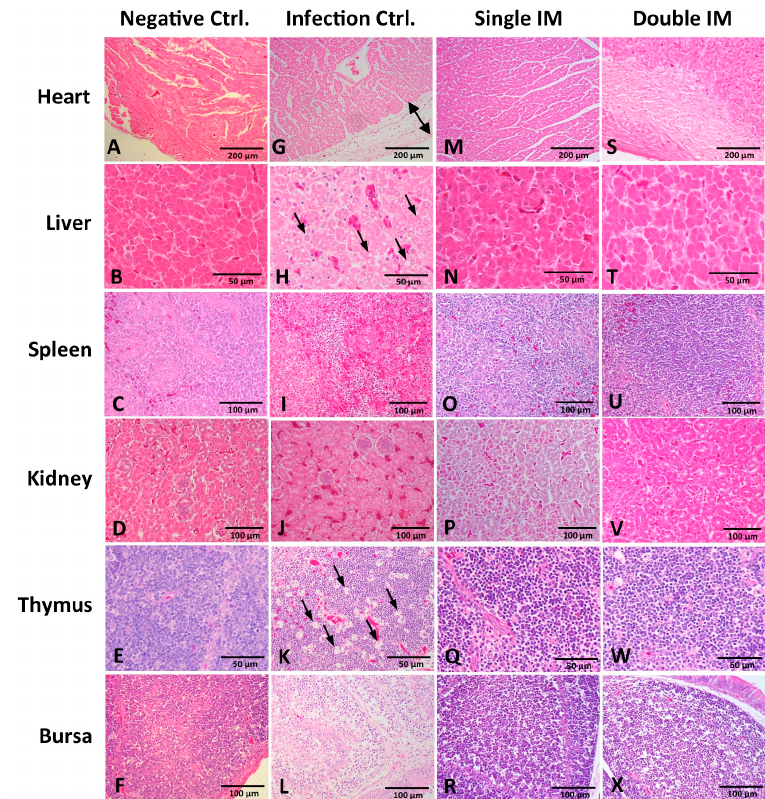
Figure 5. Histopathology in tissues at 5 days post challenge (hematoxylin and eosin (HE) stain). There was no significant histopathology change in tissues of chickens in the Negative Ctrl. group ( A – F ), Single IM group ( M – R ), and Double IM group ( S – X ). Massive pathological damages were observed in chickens of the Infection Ctrl. group: ( G ) severe edema and a small amount of inflammatory cells appeared in the epicardium of the heart. ( H ) Degeneration, vacuolar necrosis and basophilic inclusion bodies presented in liver cells. ( J ) no obvious changes showed in the kidney. ( K ) Large numbers of macrophage proliferations and cortical lymphocyte depletion appeared in the thymus. Severe reduction and necrosis of lymphocytes showed in the spleen ( I ) and bursa ( L ).